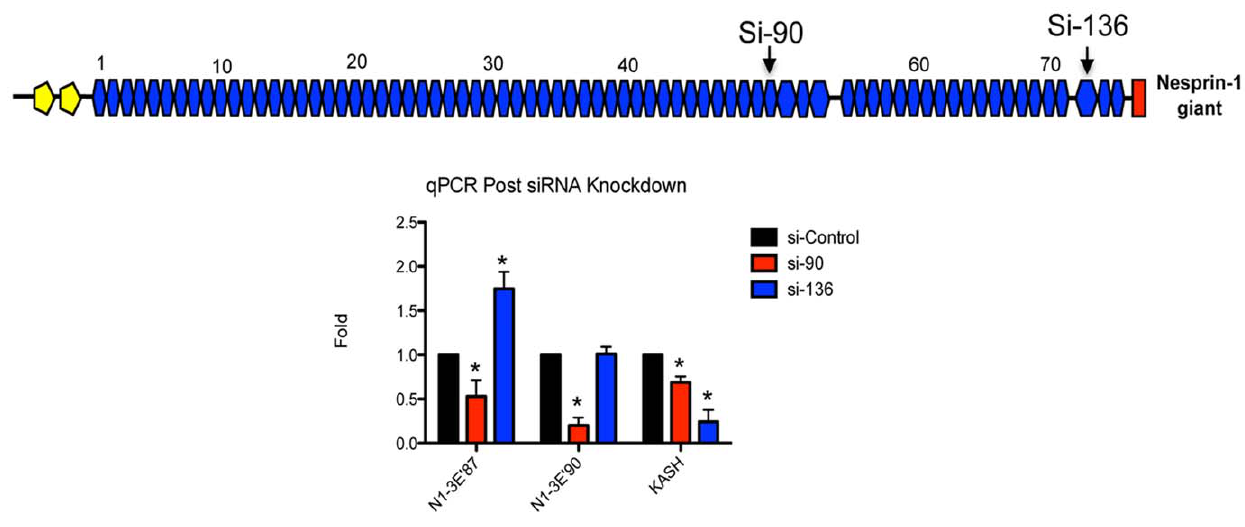
Figure 6. Nesprin-1 expression is highly adaptable. Expression levels of N1-3 9 E87, N1-3 9 E90 and nesprin-1 KASH domain were monitored post- siRNA knockdown using siRNAs targeting exons 90 and 136 of the nesprin-1 gene. As demonstrated si-136 increased expression of N1-3 9 E87 whereas si-90 reduced it’s expression. *p , 0.01, ANOVA analysis, 95% confidence interval.